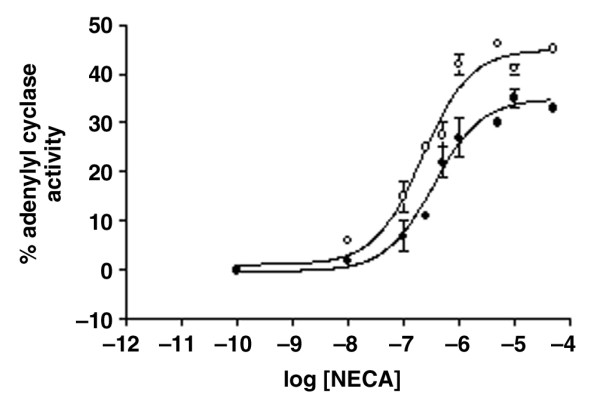
A2B adenosine receptor (AR)-mediated stimulation of adenylyl cyclase activity in control (empty circles) and systemic sclerosis (SSc; filled circles) neutrophil membranes. Membranes were incubated with different NECA concentrations (ranging from 10 nmol/l to 100 μmol/l) and the activity of adenylyl cyclase, expressed as pmol/min per mg protein, was evaluated. Values are expressed as mean ± standard error of three indipendent experiments. EC50 values were 165 ± 9.3 for control versus 373 ± 26 nmol/l for SSc.